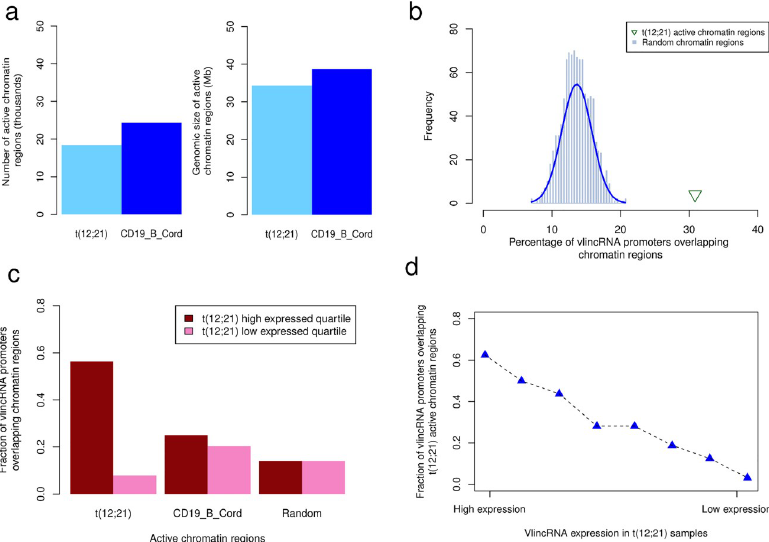
Fig 4. Epigenetic regulation at cALL vlincRNA promoters. (a) Number (left) and genomic size (right) of active chromatin regions in two t(12;21) samples and CD19 + B cord. Active chromatin regions in the t(12;21) samples were generated using ChromHMM on three chromatin marks (H3K4me3, H3K27ac and H3K4me1) and retaining states having the H3K4me3 mark present. Active CD19 + B cord chromatin regions were obtained from the Roadmap Epigenomics Project [14]by keeping states having the H3K4me3 mark present (states 1,2,3,10, and 11) from the 15-state model. (b) Percentage of vlincRNA promoters (n = 256) overlapping active t(12;21) chromatin regions (30.9%; 79 / 256) and random regions (mean 14.06%; 36 / 256). Random regions were generated a thousand times using shuffleBed from bedtools. (c) Percentage of vlincRNA promoters overlapping active t(12;21) chromatin regions, active CD19 + B cord chromatin regions and random regions in the t(12;21) high and low expressed vlincRNA quartiles (Q1 and Q4, n = 64). (d) Fraction of vlincRNA promoters overlapping active t(12;21) chromatin regions sorted by t(12;21) vlincRNA expression (8 bins of 32 promoters). HCB-B: CD19 + CD10 + pre-B cells isolated from human cord blood.